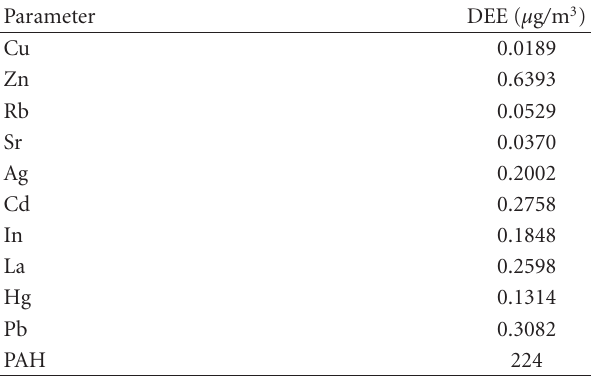
Table 2: Metal and PAH concentrations in diluted DEE.